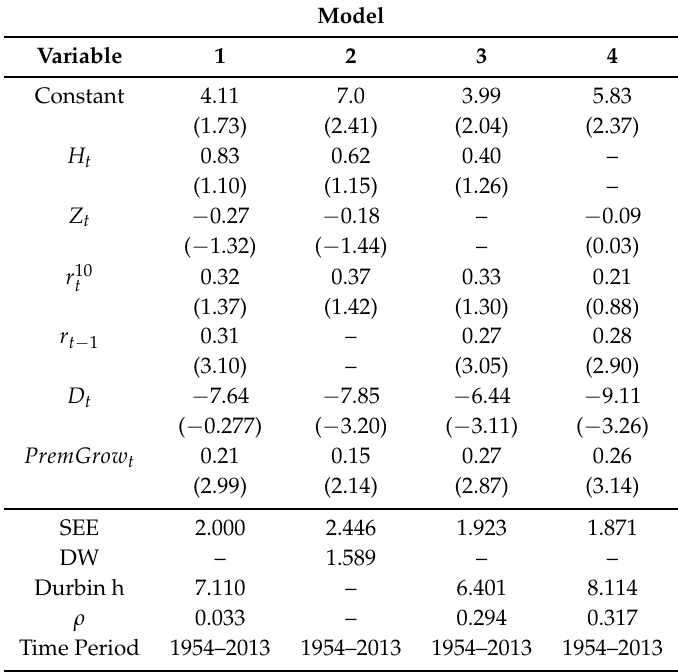
Table 1. Various specifications of the P/C return on equity model. Each column represents a different model specification. ”–” means that the variable was not included into the model. The standard error of the estimate (SEE), the value of the Durbin h-statistic ( h ), and the estimate of the first-order serial correlation coefficient for the Ordinary Least Squares (OLS) error ( ρ ) for various models are reported at the bottom.